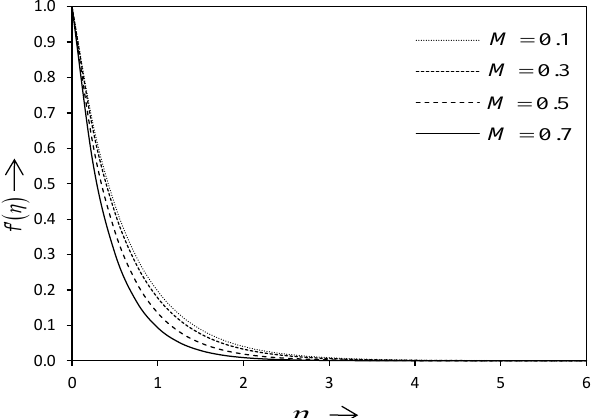
Figure 4. Velocity profiles against  for various values of M